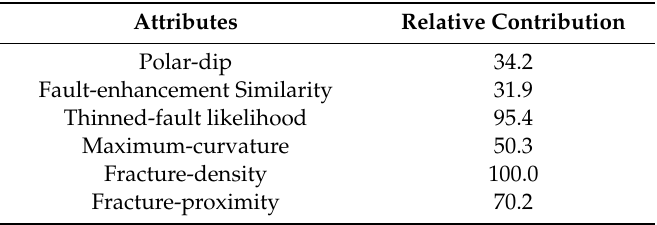
Table 1. Sensitivity table illustrating the input node relative weights of every attribute used for the